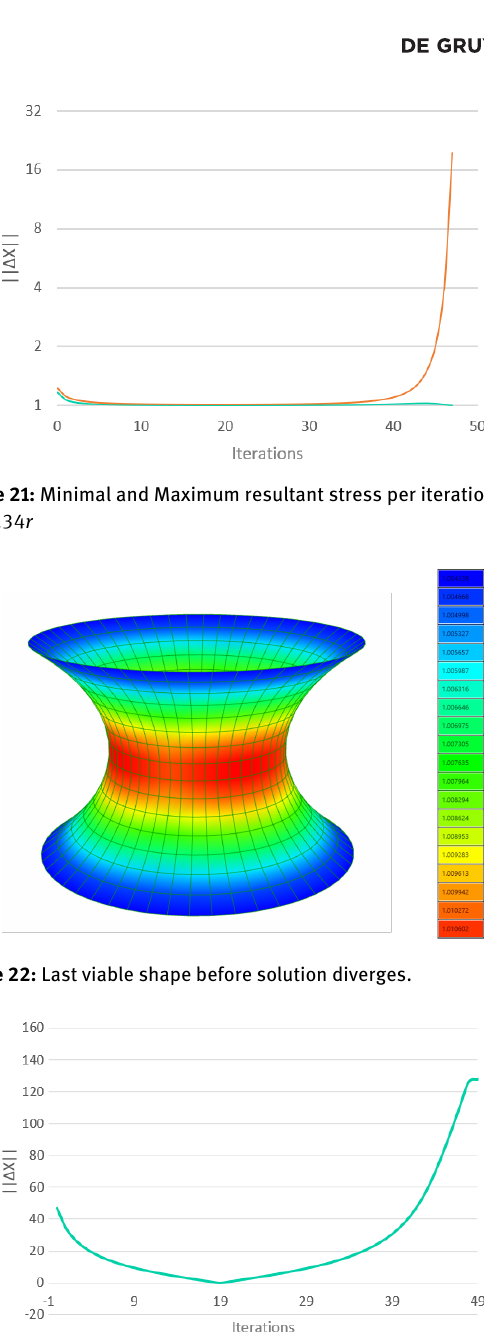
Figure 23: Comparison between the last viable shape and corre- sponding iteration resultant geometry h = 1.34 r